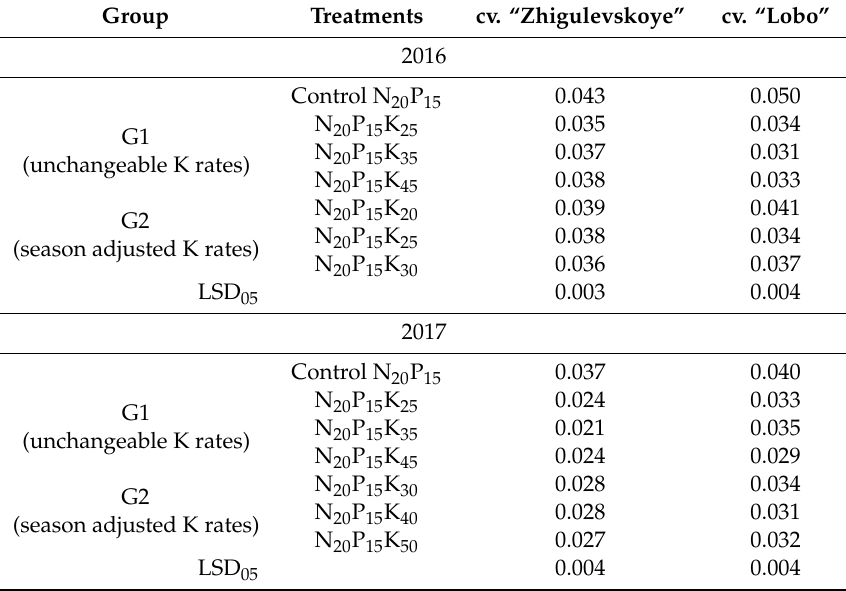
Table 16. The e ff ect of di ff erent potassium fertilization rates and fertigation approaches on the calcium fruit status, % d.m.